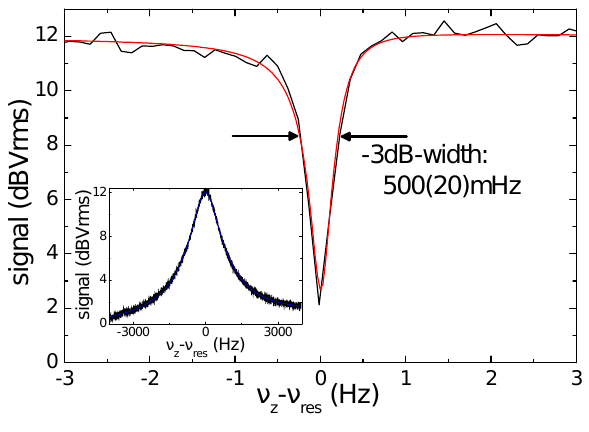
Figure 2. Fourier transform of the noise voltage across the axial resonance circuit attached to a trap electrode in the presence of a single trapped 12 C 5 + ion. The ion shortens the noise of the resonator and generates a dip signal with a full width at half maximum (FWHM) of 0.5 Hz. The total oscillation frequency of about 670kHz can be determined from the fitted lineshape (red line) with an uncertainty of 100mHz. The insert shows the complete resonator and the corresponding fit (blue